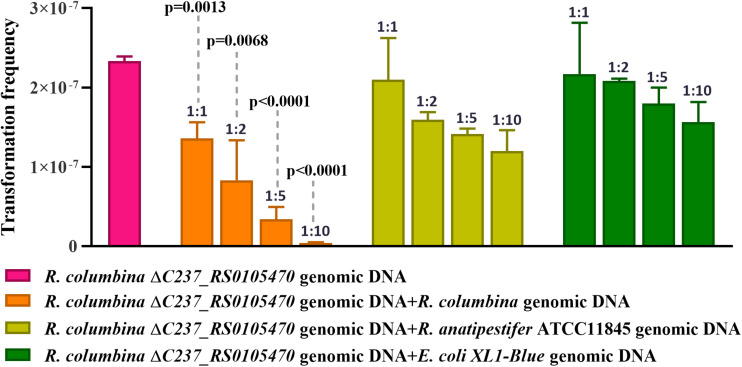
Natural transformation competition experiments. R. columbina was cultured to the logarithmic phase (3–4), and the OD600 value was determined. The cell culture was adjusted to an OD600 of 1. A 300 μl cell culture was transformed with 1 μg the genome of R. columbina ΔC237_RS0105470 (control) or 1 μg of donor DNA mixed with different quantity of competing genomic DNA of R. columbina, R. anatipestifer ATCC11845 or E. coli XL1-Blue and incubated at 37°C for 1 h. The natural TF was calculated as transformants divided by viable bacteria. The P-value refers to the difference between the no-competition and competition measurement, respectively. Insignificance p-value (P > 0.05) was not shown. All the results are representative of three independent experiments. Error bars denote standard deviation.